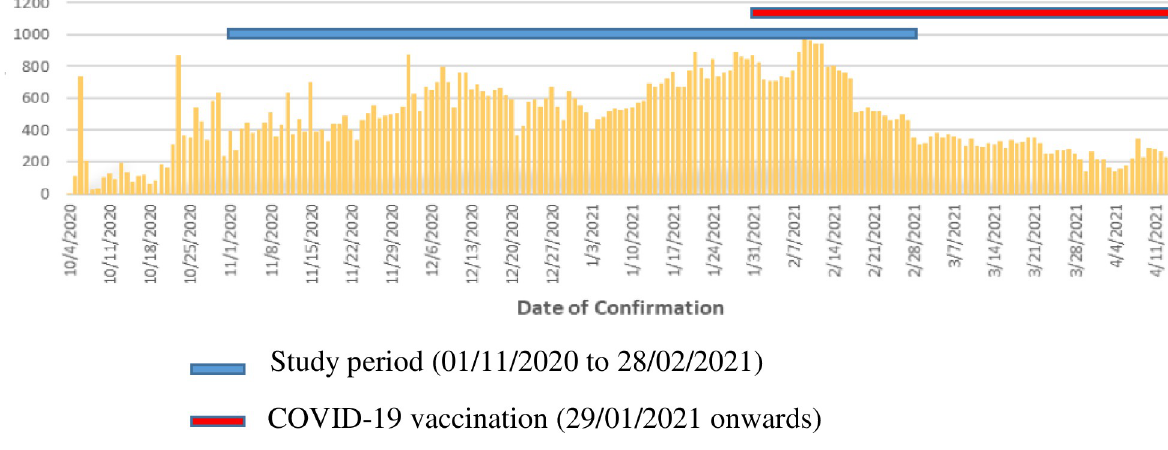
Fig 1. Epidemiological curve: COVID-19 2nd wave, Sri Lanka (04/10/2020 to 4/04/2021) [5].